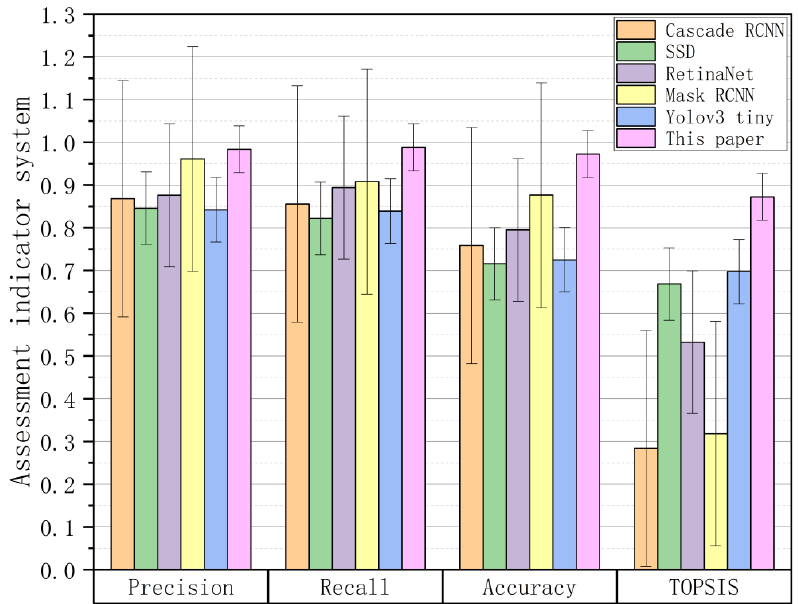
Figure 14. Bar graph comparing the performance of different methods.